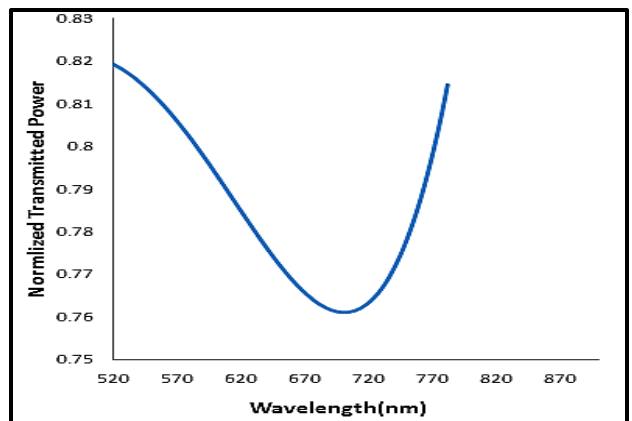
Fig.9: Normalized transmitted power obtained through a sensor fiber, metallized with gold of thickness d=40 nm, L= 10 mm, D= 980 ) immersed in a solution having an index n = 1.39. This curve is calculated directly from the spectra of